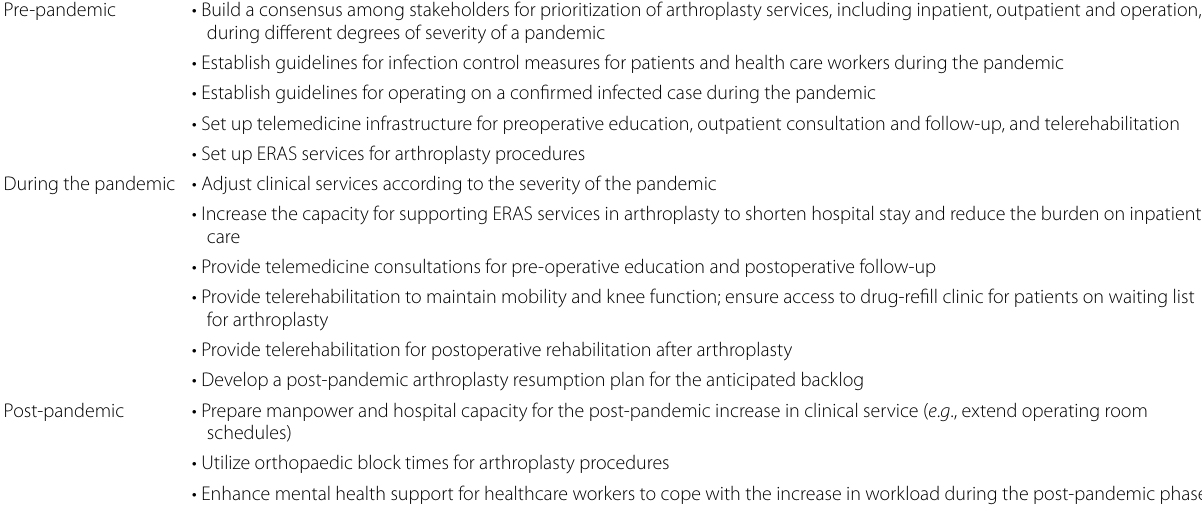
Table 5 Strategies for arthroplasty service planning during the next pandemic